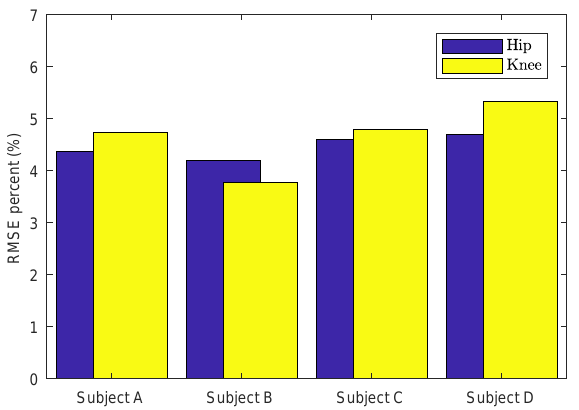
Figure 17. RMSE comparison of torque error for four human